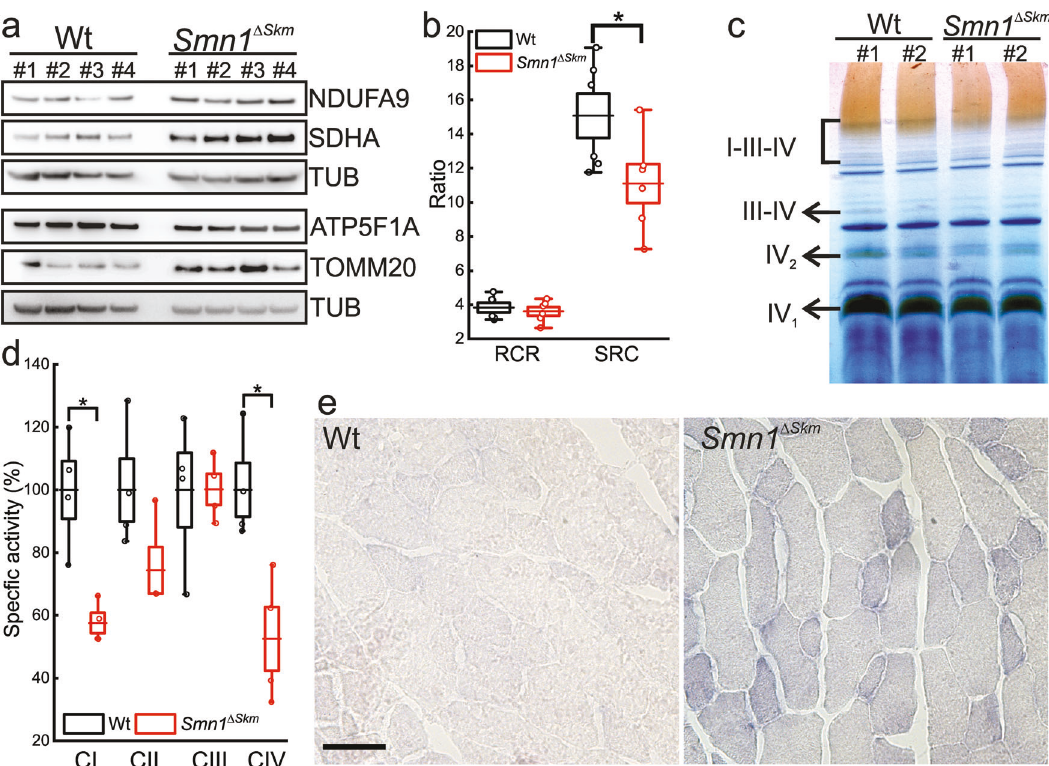
Fig. 4 Skeletal muscle mitochondria of Smn1 Δ Skm mice show altered functionality. a Equal amounts of TA muscle lysates (20 µg) were separated by SDS-PAGE and immunoblotted using the indicated antibodies. Each lane corresponds to an individual mouse of the indicated genotypes. Densitometry analysis yielded the following values: NUDFA9: 0.56 ± 0.05 in Wt ( n = 4) and 0.9 ± 0.05 in Smn1 Δ Skm ( n = 4), p = 0.03; SDHA: 0.28 ± 0.034 in Wt ( n = 4) and 0.64 ± 0.036 in Smn1 Δ Skm ( n = 4), p = 0.03; ATP5F1A: 1.09 ± 0.12 in Wt ( n = 4) and 1.57 ± 0.08 in Smn1 Δ Skm ( n = 4), p = 0.03; TOMM20: 0.5 ± 0.07 in Wt ( n = 4) and 1.44 ± 0.26 in Smn1 Δ Skm ( n = 4), p = 0.03. TUB is used as loading control. b Box-dots plots of respiratory control ratio (RCR) and spare respiratory capacity (SRC) measured in mitochondria isolated from skeletal muscles of Wt and Smn1 Δ Skm mice ( n = 3). The error bars indicate SEM; * p = 0.045. c BNGE-in-gel activities of MRC CIV from BNGE of digitonin-treated isolated mitochondria from the indicated genotypes. d Mitochondria respiratory chain enzymatic activities normalized by citrate synthase activity in isolated muscle mitochondria from Wt and Smn1 Δ Skm muscle ( n = 4). e Representative images of gastrocnemius muscle sections from mice of the indicated genotype stained with the NBTx method. Scale bar: 50